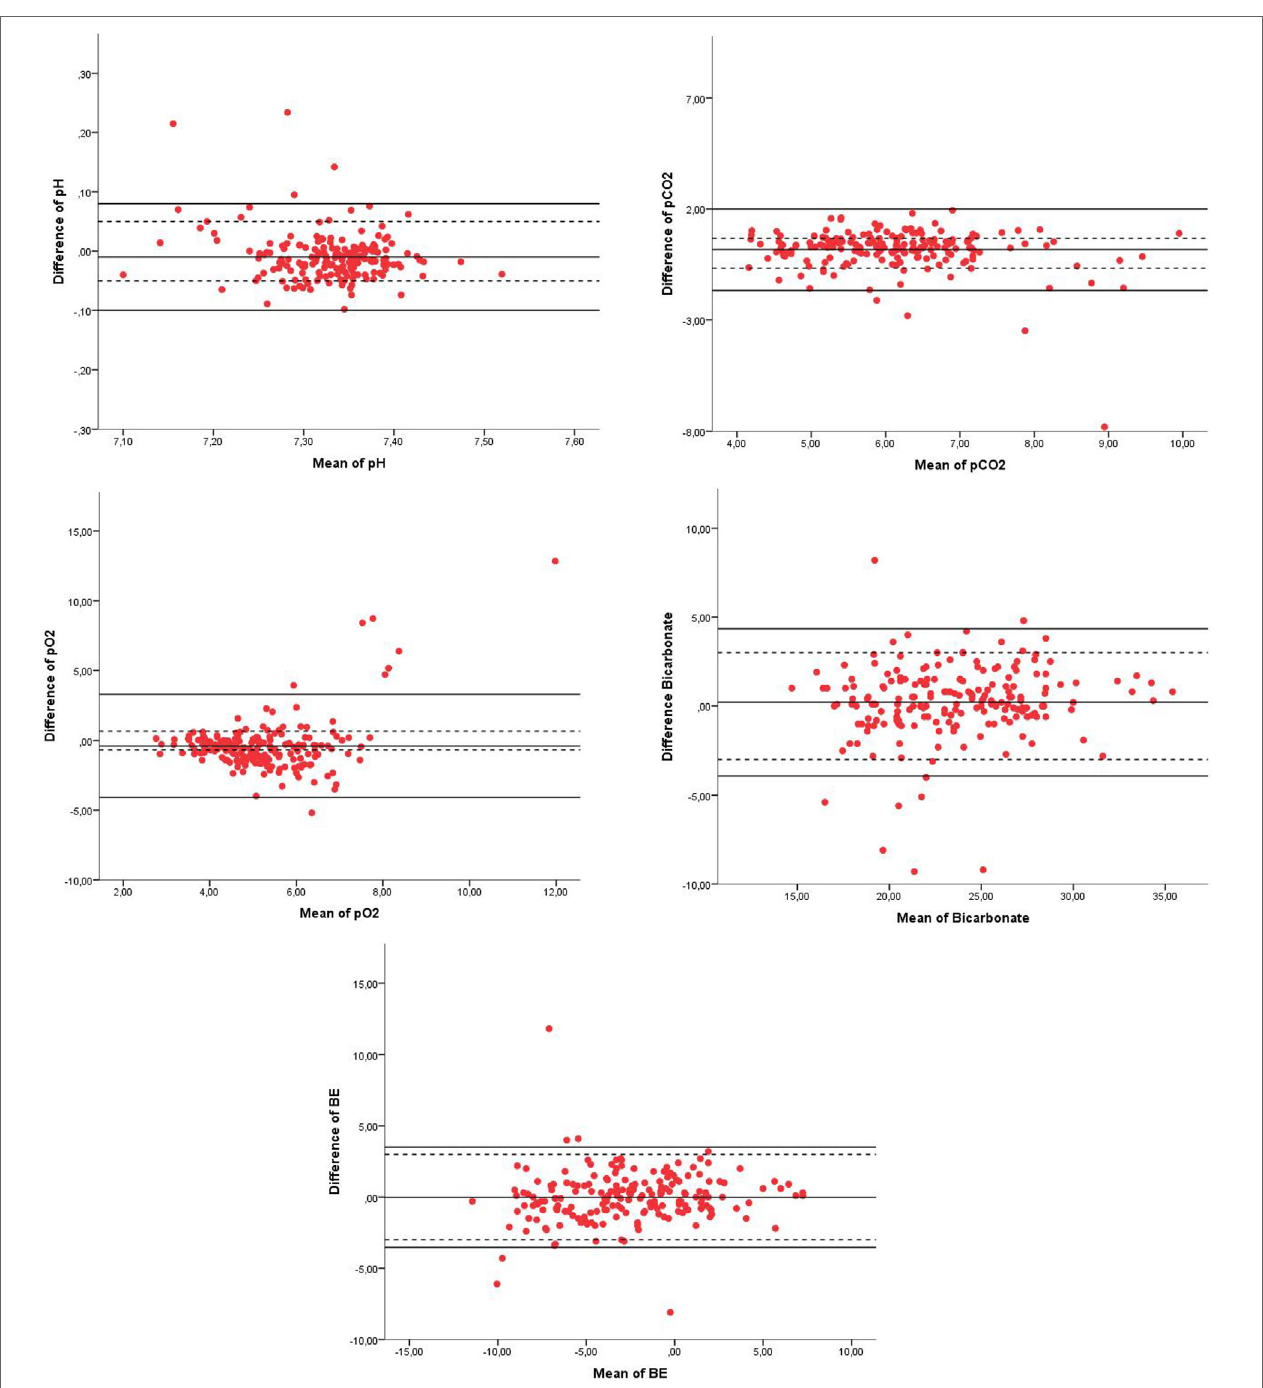
FigUre 2 | Bland–Altman plots of pH, pCO 2 , pO 2 , bicarbonate, and BE of venous blood gas (VBG) and capillary blood gas (CBG). Legend of the Bland–Altman plots: X = mean of pH, pCO 2 (kpa), pO 2 (kpa), bicarbonate (mmol/1), or BE (mmol/1), Y = difference of the parameter of pH, pCO 2 (kpa), pO 2 (kpa), bicarbonate (mmol/1), or BE (mmol/1), red dots = measurement of each paired sample of VBG and CBG, solid black line = 95% confidence interval limits, and dotted line = clinical acceptable absolute